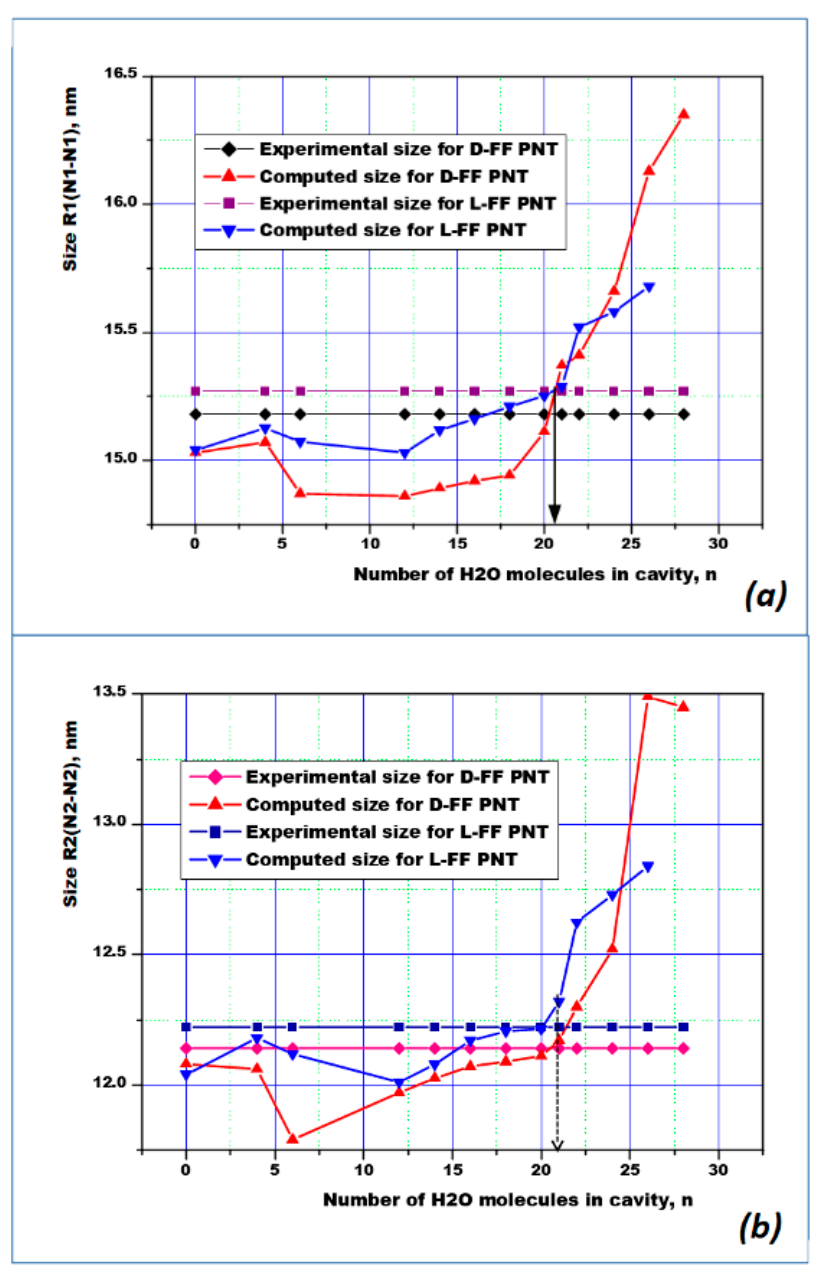
Figure 3. Dependences of the internal cavity sizes of the optimized structures of nanotubes of both types of chirality L-FF and D-FF containing a different number of water molecules on the number n of these water molecules, in comparison with the known sizes of the internal sizes of nanotubes according to experimental data (Table 2) [25,29,33,39]: ( a ) R 1 —between the nitrogen atoms N 1 ...N 1 (larger “distant” diameter PNT); ( b ) R 2 —between the nitrogen atoms N 2 ...N 2 of the opposite NH3 + groups (short “near” inner diameter PNT).